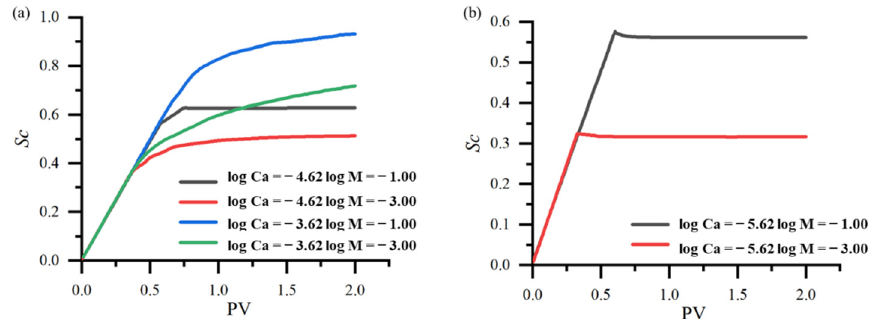
Figure 6. CO 2 saturation ( S C ) vs. PV number for different Ca and M ( a ) CO 2 saturation ( S C ) as a function of PV (log Ca = − 3.62 and − 4.62); ( b ) CO 2 saturation ( S C ) as a function of PV (log Ca = − 5.62).